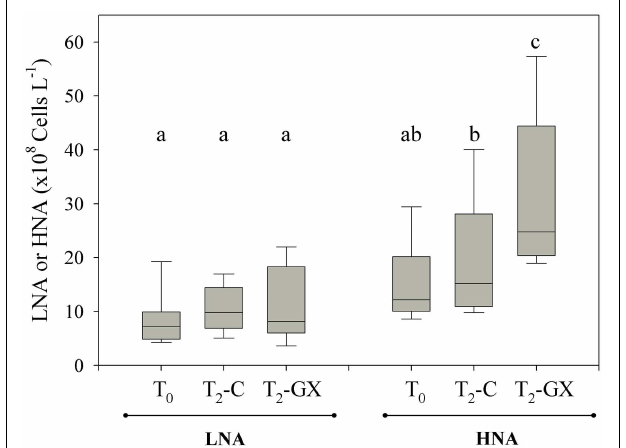
FIGURE 5 | Changes in heterotrophic bacterial community composition following GX addition (GX) compared to un-amended controls (C) during the experimental microcosm 2 days incubations (T 0 –T 2 ). The bacterial community was segregated into two subgroups containing high and low nucleic acid content (HNA and LNA, respectively). Each box plot represents microcosms that were carried with water samples from the surface and bottom of stations E1–E3. Differences between HNA and LNA were evaluated using One-Way ANOVA followed by Fisher LSD multiple comparison post-hoc test with a confidence of 95%.